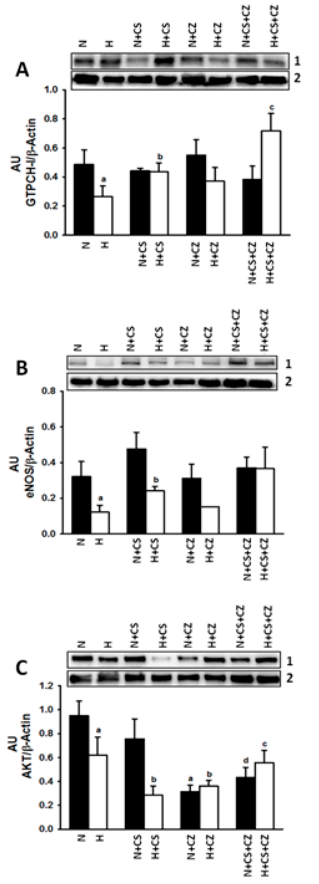
Figure 5. Expression of guanosine triphosphate cyclohydrolase 1 (GTPCH-1), endothelial nitric oxide synthase (eNOS), protein kinase B (AKT) in ventricular tissue from normotensive and hypertensive rats (black and white bars respectively) with the di ff erent treatments. Panel ( A ): GTPCH-1 expression in ventricular tissue ( n = 3–4 rats / group); a = p < 0.05 vs. Normotensive (N), b = p < 0.05 vs. Hypertensive (H), c = p < 0.05 vs. Hypertensive + Capsaicin (H + CS). Panel ( B ): eNOS expression in left ventricle ( n = 3–4 rats / group); a = p < 0.05 vs. Normotensive (N), b = p < 0.05 vs. Hypertensive (H). Panel ( C ): AKT expression in left ventricle ( n = 3–4 rats / group). a = p < 0.05 vs. Normotensive (N), b = p < 0.05 vs. Hypertensive (H), c = p < 0.05 vs. Hypertensive + Capsaicin (H + CS), d = p < 0.05 vs. Normotensive + Capsaicin (N + CS). z = Representative immunoblot. By Duncan’s post hoc test. Data are presented as means ±